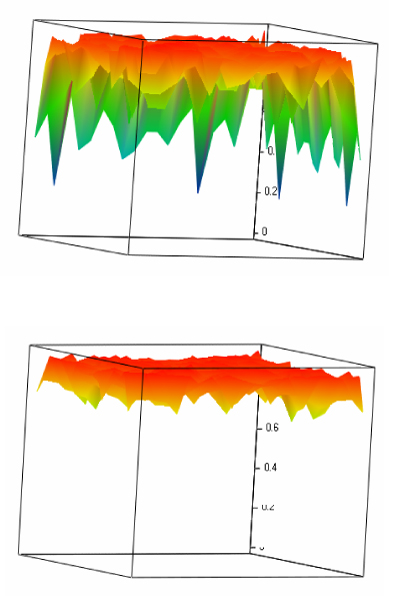
Comparison of spectral quality before and after low quality spectra are detected by the correlation matrix and discarded. The quality of spectra from biological replicates of quality control samples is illustrated in the Pearson correlation matrix surfaces that were generated using the software DMVS 2.0 (Shenzhen Chipscreen Biosciences, Ltd, Shenzhen, P. R. China, ). The x and y axes represent spectra and the z-axes indicate the values of Pearson correlation coefficients. The bright red color indicates very good correlation with values of R close to 1, and the green color indicates that a low correlation was observed between two spectra. (A) Correlation matrix was applied to the dataset prior to quality control. Green valleys caused by several low quality spectra that had very low correlations to most of other spectra were detected. (B) After the low quality spectra were detected by the correlation matrix and discarded, the Pearson correlation matrix surface became clear and very red, indicating that the majority of the correlations among all spectra are very high.